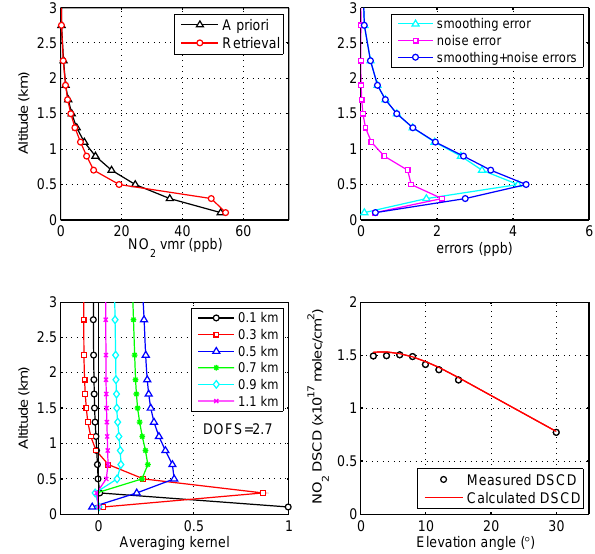
Fig. 2. Example of HONO vertical profile retrieval (Beijing, 21 Jan- uary 2009, ∼ 10:15 local time). The upper plots display the a pri- ori and retrieved profiles (left) and the smoothing and noise errors (right). Averaging kernels and fit results (comparison between mea- sured DSCDs and those calculated with the retrieved profile) are shown in the lower plots. Error bars on the measured DSCDs are the DOAS fit errors.